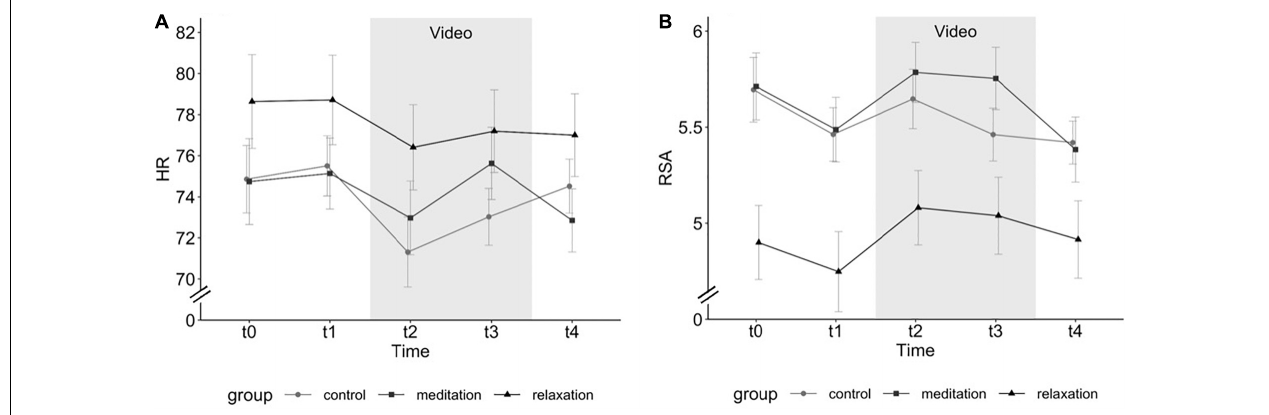
FIGURE 3 | (A) Heart rate (HR) and (B) respiratory sinus arrhythmia (RSA) over time in study 2 (t0: baseline, t1: first set of questionnaires, t2: first half of video, t3: second half of video, t4: second set of questionnaires) in all three groups: nature-based relaxation video, meditation video, control video; error bars depict standard errors of the mean.